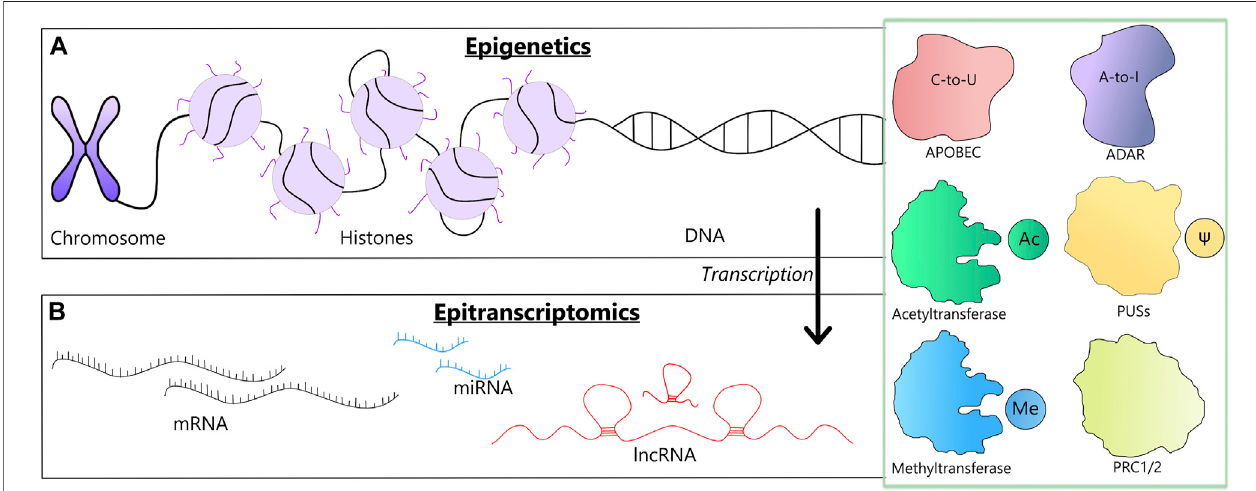
FIGURE1| Aschematic representation oftwo levels at which thereviewed modi fi cations may occur alongwith theinvolved enzymes(a green box). (A) Epigenetic changes could involve chromosome remodeling, histone modi fi cations and DNA methylation. (B) Epitranscriptomic changes, involve changes in mRNAs, tRNAs and lncRNAs, such as RNA editing, m6A modi fi cation and pseudouridilation.